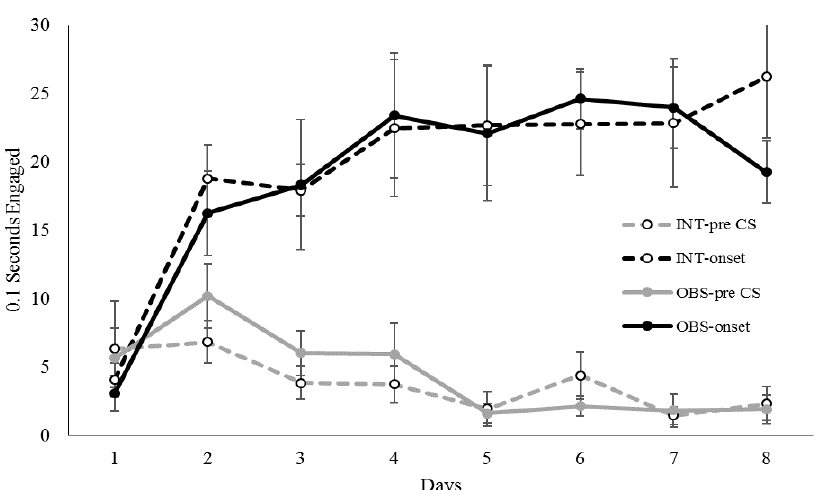
Figure 1. Nosing of the food trough in 10-second periods immediately prior to CS presentation (pre CS), and beginning from CS onset (onset) for intervened upon stimuli (INT) and control stimuli (OBS) in Experiment 1. Error bars indicate